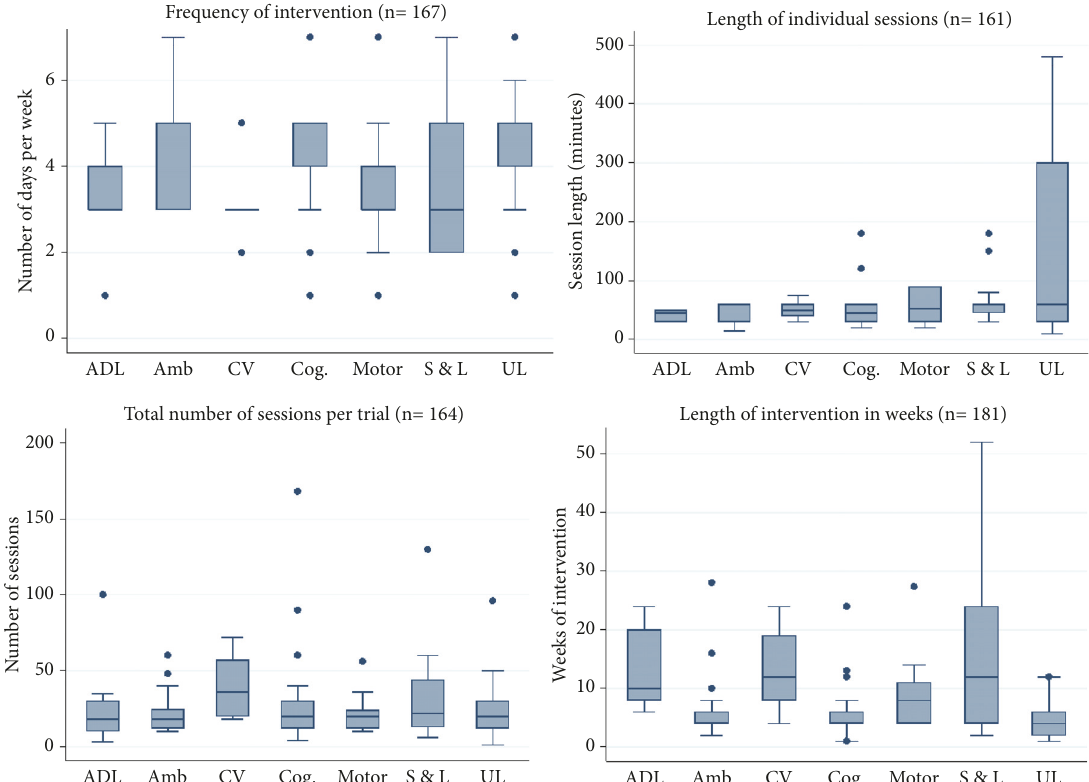
Figure 2: Dose schedule by intervention type Note . N in graph heading= number of trials that contained a report of this item. Type of intervention: ADL=activity of daily living, amb= balance or mobility, cog.= cognition or neglect, CV= cardiovascular or strength, motor= motor control, S & L= speech and language, and UL= upper